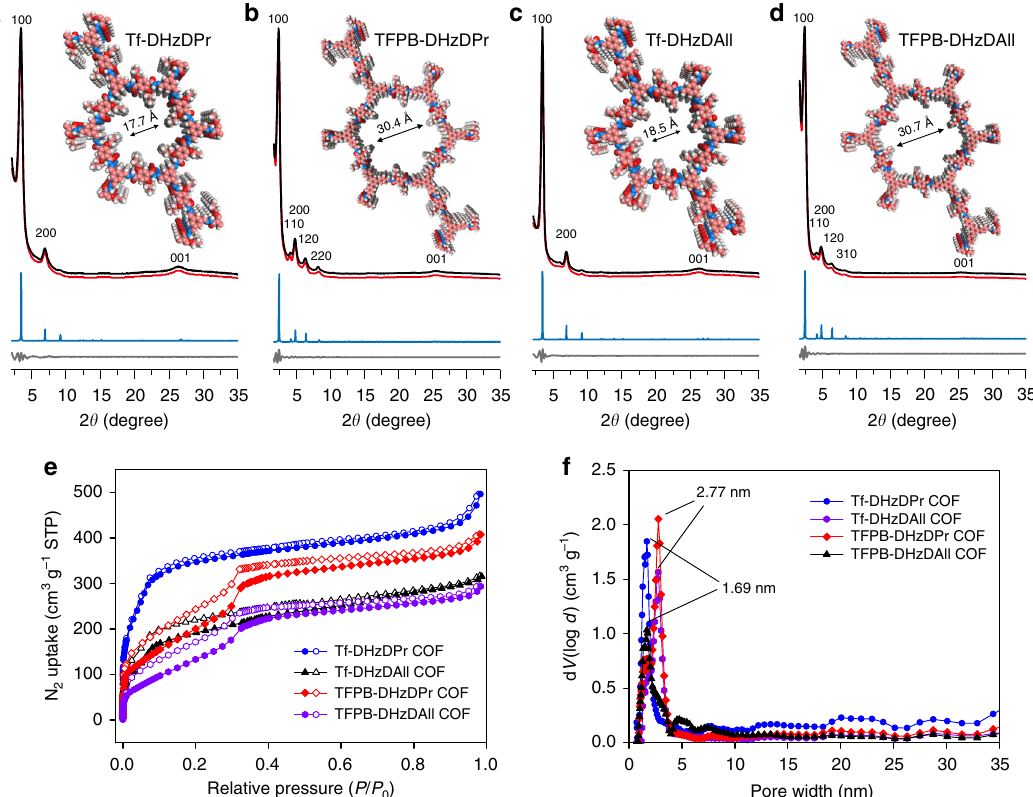
Fig. 3 Characterization of selected COFs. Experimental (black), Pawley re fi ned (red), their difference (grey) and simulated eclipsed stacking (blue) PXRD patterns of a Tf-DHzDPr COF, b Tf-DHzDAll COF, c TFPB-DHzDPr COF and d TFPB-DHzDAll COF. (Inset: re fi ned eclipse structures with simulated pore sizes. C, pink; N; blue; O, red; and H, white.) e Nitrogen sorption isotherms. f Pore size distribution of the Fig. 2 and Supplementary Fig. 1. A series of nine COFs with different pore sizes and side-chain functionalities were designed and synthesized. We used three different aldehydes, 2,5-dime-